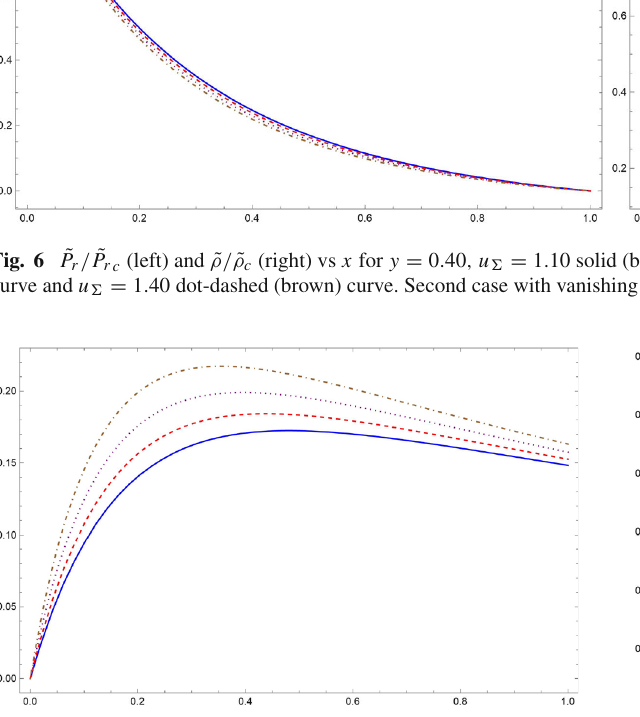
Fig. 7 ˜ (cid:8)/ ˜ P rc vs x for y = 0 . 40 , u (cid:5) = 1 . 10 solid (blue) curve, u (cid:5) = 1 . 20 dashed (red) curve, u (cid:5) = 1 . 30 dotted (purple) curve and u (cid:5) = 1 . 40 dot-dashed (brown) curve. Second case with vanishing complexity using F-S as seed